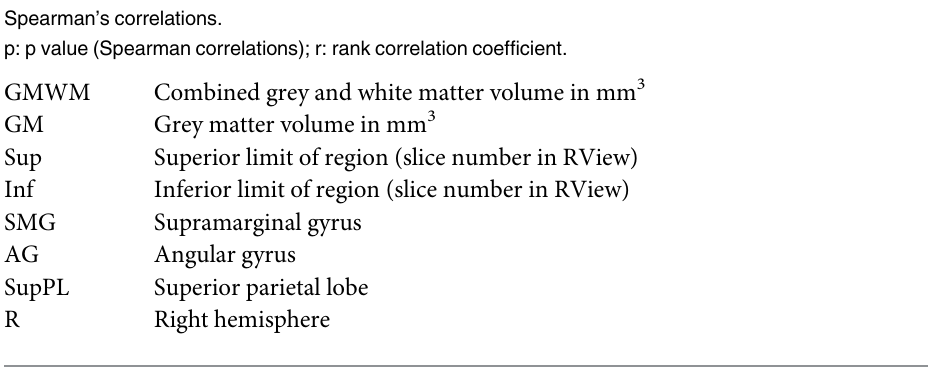
Relationships between the morphological characteristics and other variables listed in Tables 1 and 2. Spearman’s correlations.